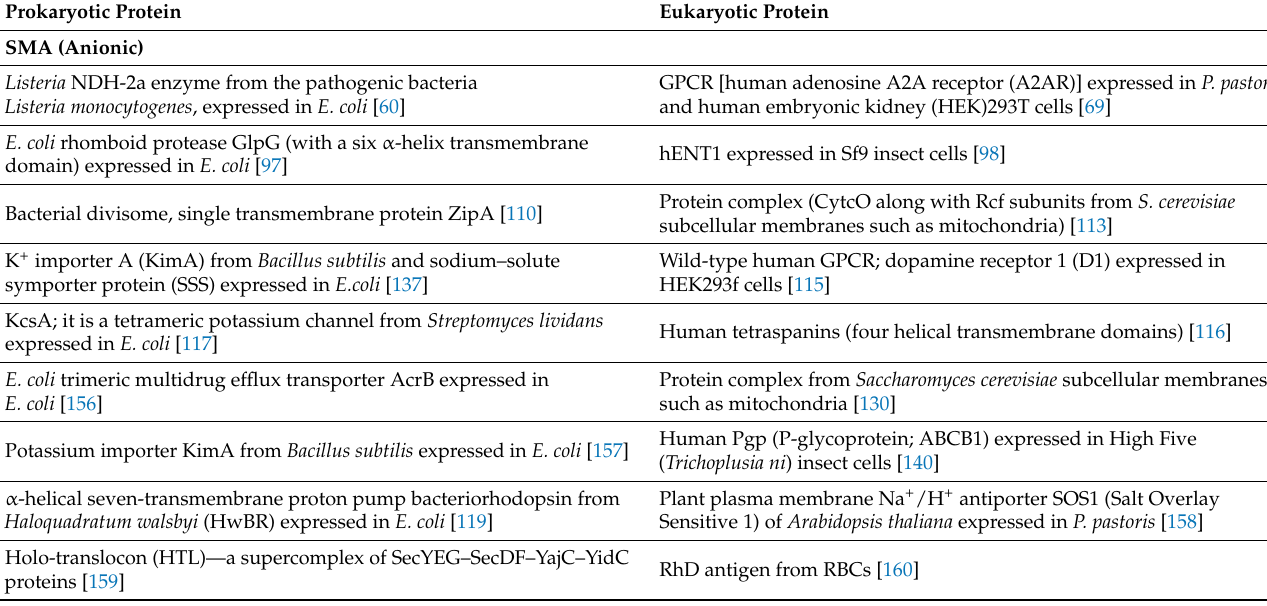
Table 4. List of membrane proteins isolated using polymers under detergent-free conditions. Prokaryotic Protein Eukaryotic